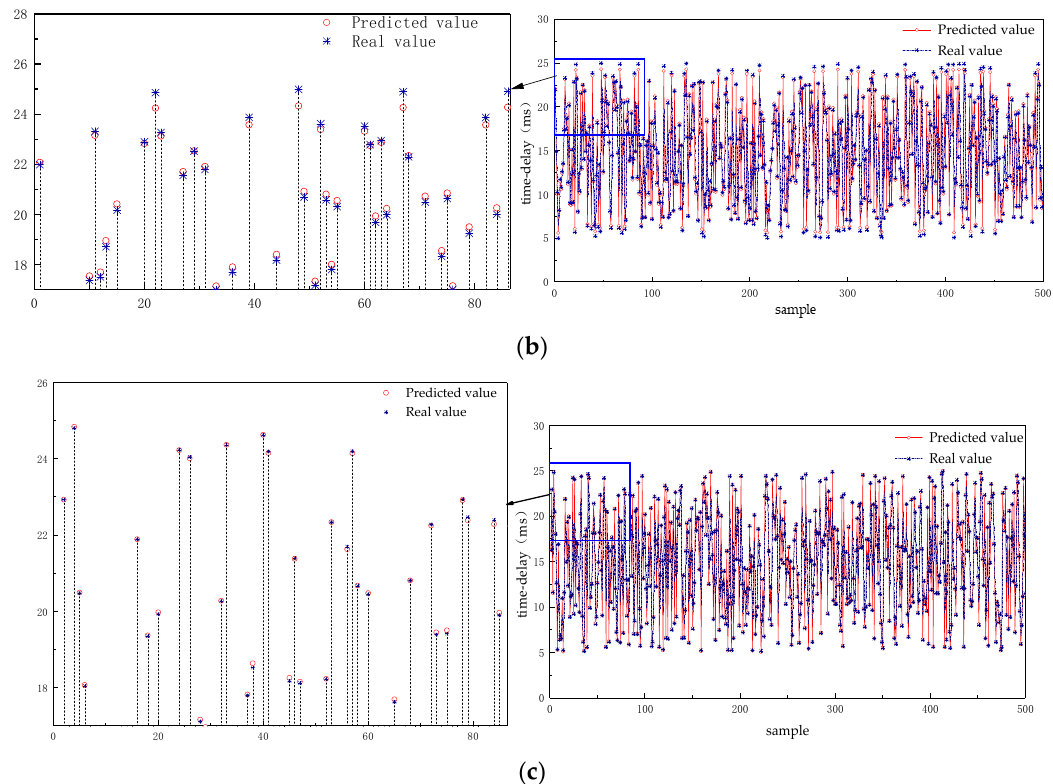
Figure 9. Comparison of forecasts from different forecasting algorithms, of which ( a ) shows the comparison of BP neural network prediction, ( b ) shows the comparison of RBF neural network prediction, and ( c ) shows the comparison of improved PSO-RBF neural network prediction.